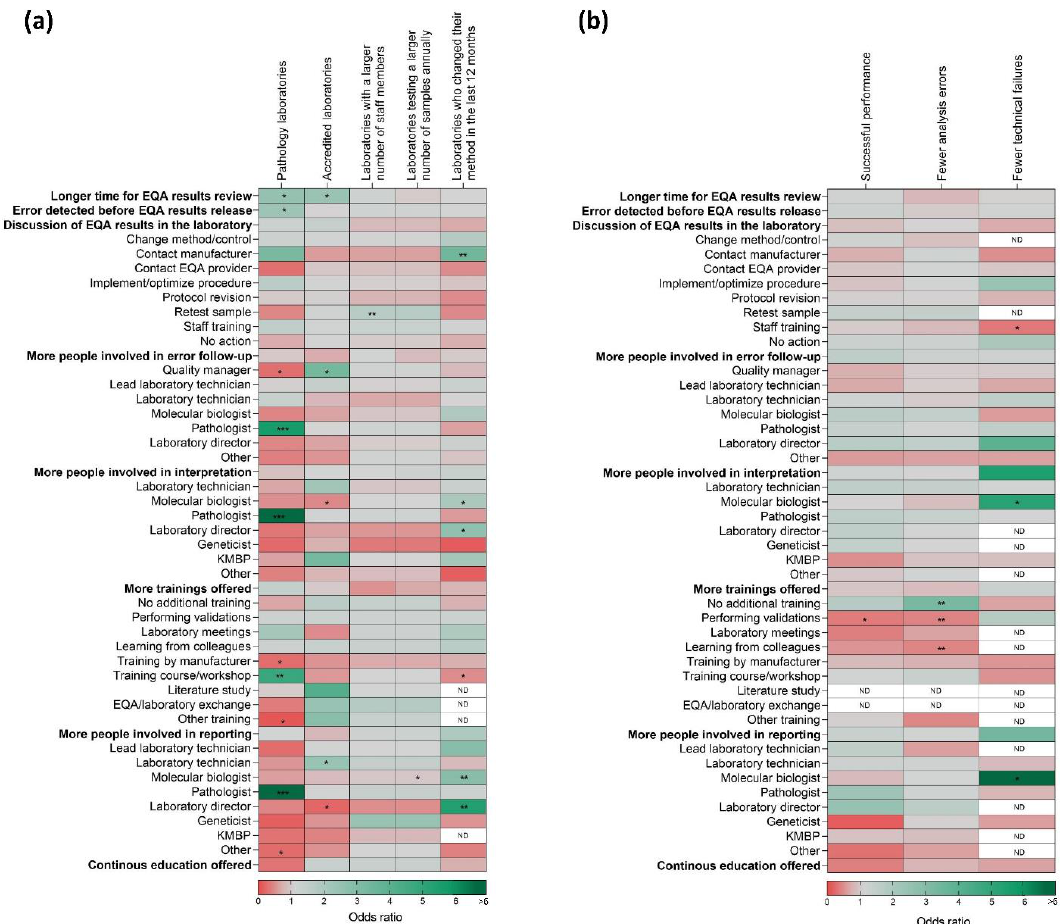
Figure 1. Survey answers related to probability of ( a ) different laboratory characteristics and ( b ) performance in the next EQA scheme; logistic regression models or proportional odds ratios with generalized estimating equations (GEE) were used. Odds ratios > ( < ) 1 reflect a higher (lower) probability for the action to be related to the laboratory characteristic / EQA